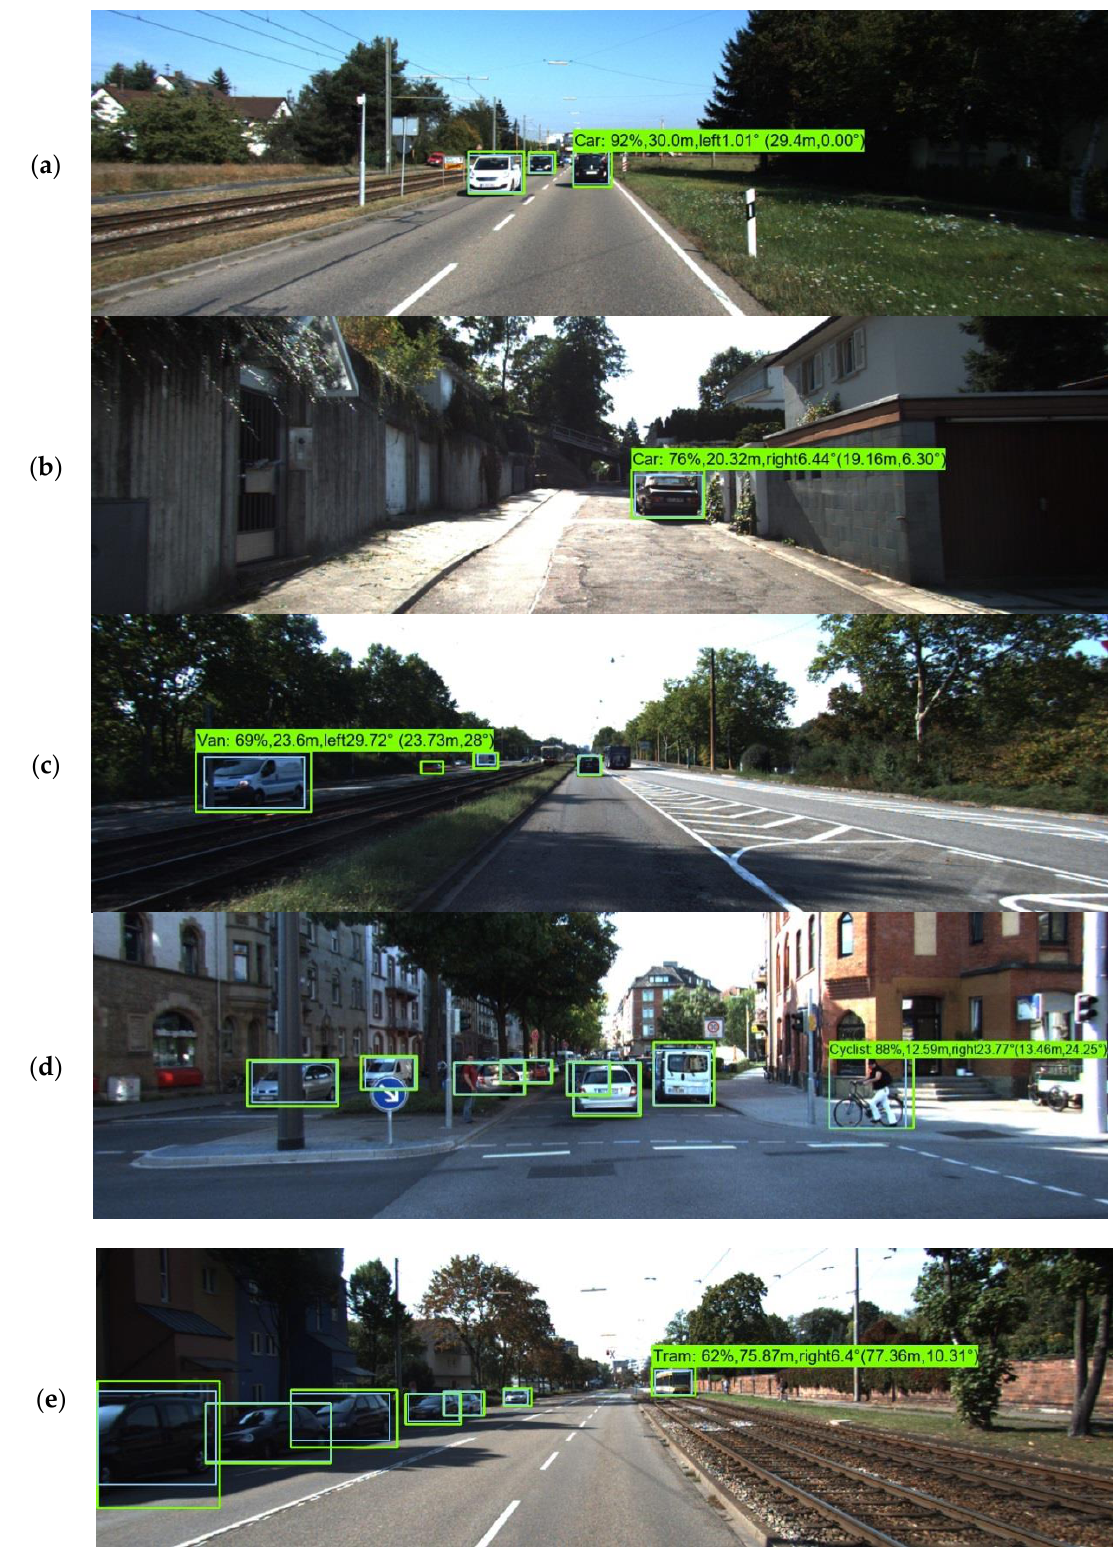
Figure 7. The outputs of SegYOLO and PRS pipeline (a-e). To keep clear, we have marked only one depth and angle estimation result on each figure, with ground truth in parentheses.